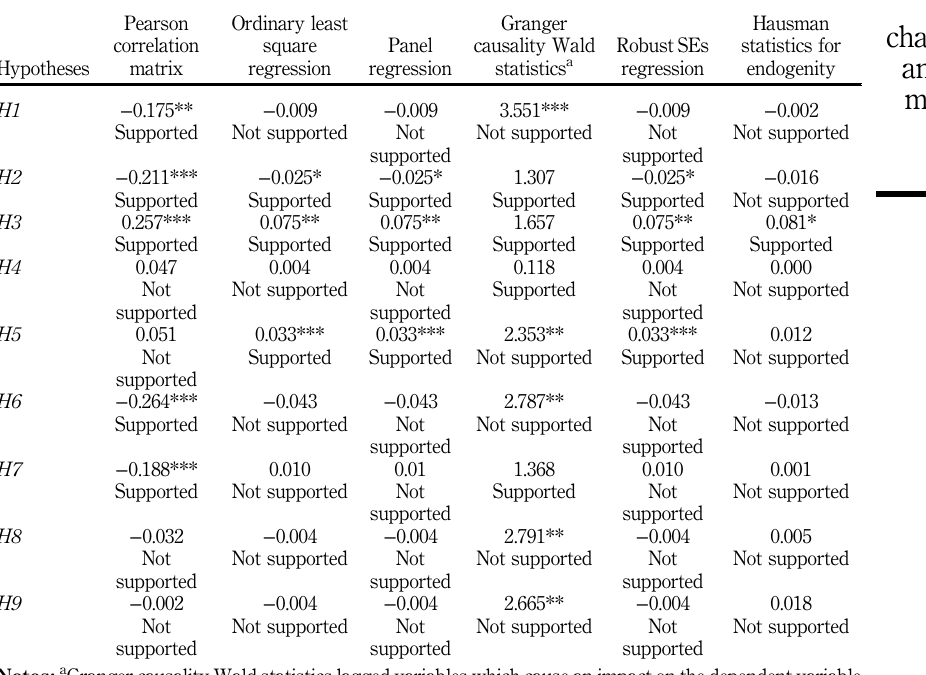
Table VIII. Summary of the results of the statistical